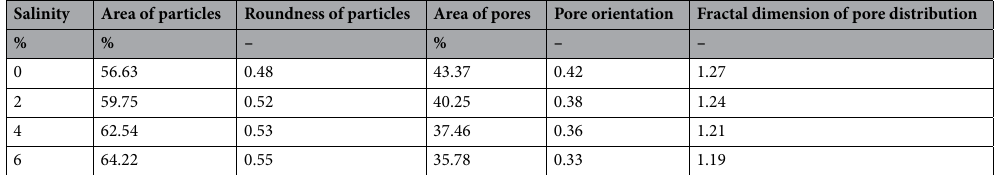
Table 6. Microscopic morphological parameters of soft marine clay with different